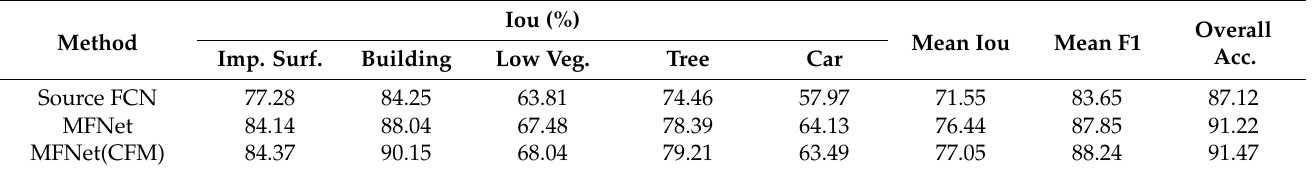
Table 4. MFNet & source FCN & MFNet (CFM) accuracy in the Vaihingen dataset.